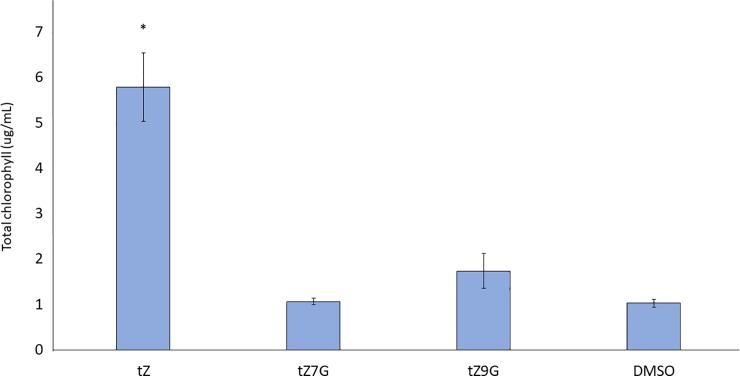
trans-Zeatin-N-glucosides do not delay senescence in trans-Zeatin biosynthetic mutants.Cotyledons from 12dag cypDM mutants, which are deficient in tZ-type cytokinins, were subjected to a 6d-long cotyledon senescence assay. While exogenous tZ delayed senescence, tZNGs did not. Average ± SE of four independent biological replicates is presented. *p<0.05, Student’s two-tailed t test.